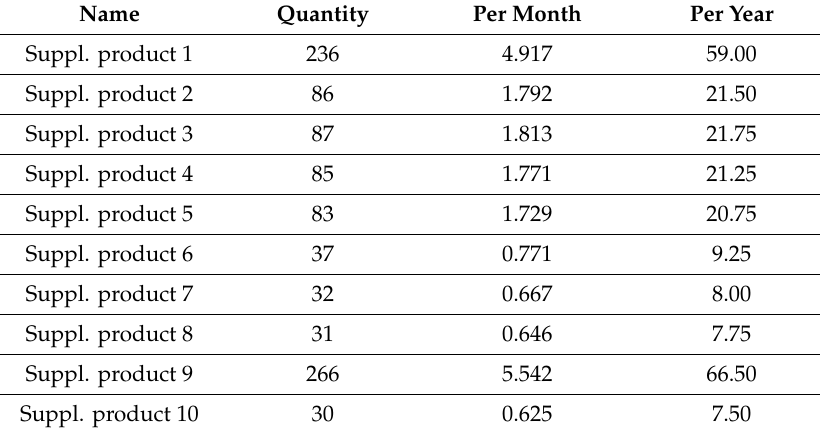
Table 2. Most frequent products from suppliers in the period 2012–2015.